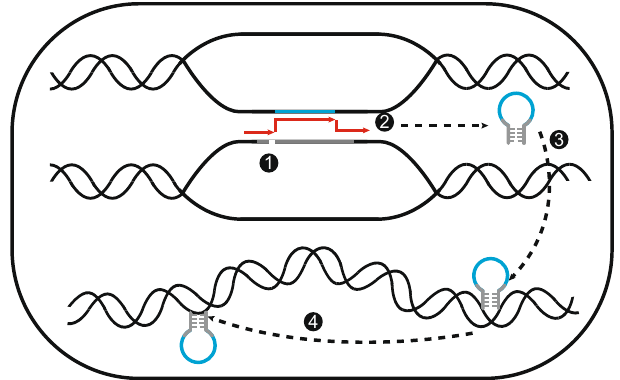
Fig. 6 Working model of FoSTeST. The model includes four steps: (1) replication fork stalling; (2) template switching; (3) transposition; and (4) potential ampli fi cation via a new round